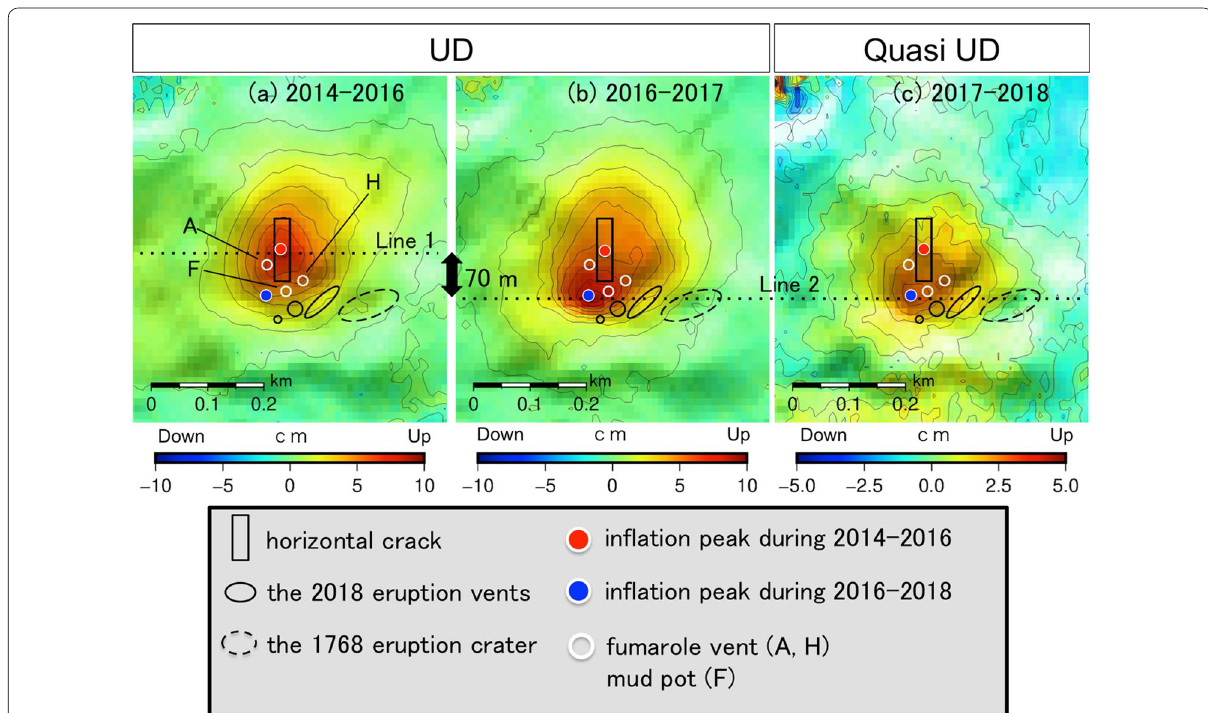
Fig. 6 Migration of the inflation peak. Spatial distribution of uplift and quasi uplift for a 2014–2016, b 2016–2017, and c 2017–2018 around the eruptive vents formed on April 19, 2018. Line 1 and 2 indicate the meridian running through the inflation peaks during 2014–2016 and 2016–2018. The black arrow indicates migration distance between inflation peaks during 2014–2016 (red points) and 2016–2018 (blue points). The white circles indicate fumarole vents A and H and mud pot F. The black solid and dashed ellipsoids indicate the eruptive vents generated in the 2018 eruption and the 1768 eruption, respectively. The rectangles indicate sill-like crack geometry estimated during